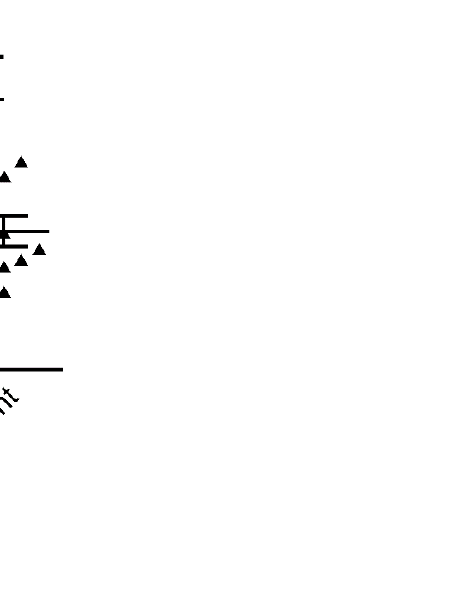
Figure A2. Fluorescence intensity in the no treatment group ( n = 7), NSAIDs ( n = 11), and presniso- lone ( n = 3). Fluorescence intensity is expressed as a ratio of the amount of fluorescence in the 5- ALA supplemented group relative to the amount of fluorescence in the vehicle group for each sam- ple. The horizonal lines indicate the mean ± SD.